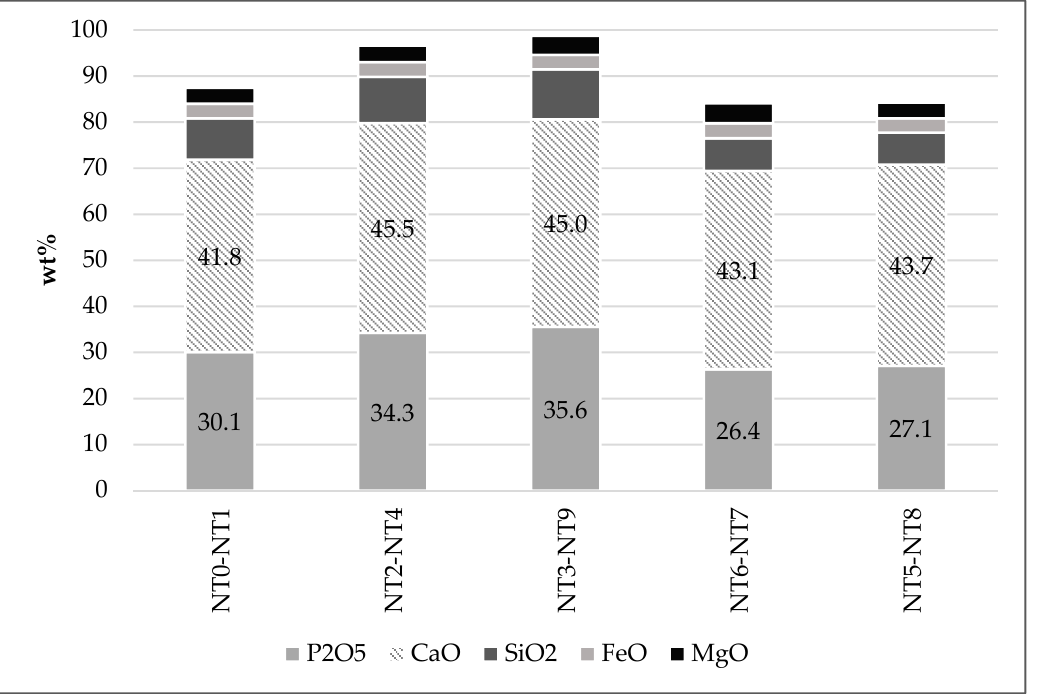
Figure 4. Slimes chemical composition for tests 1 (NT1) to 9 (NT9), wt%.